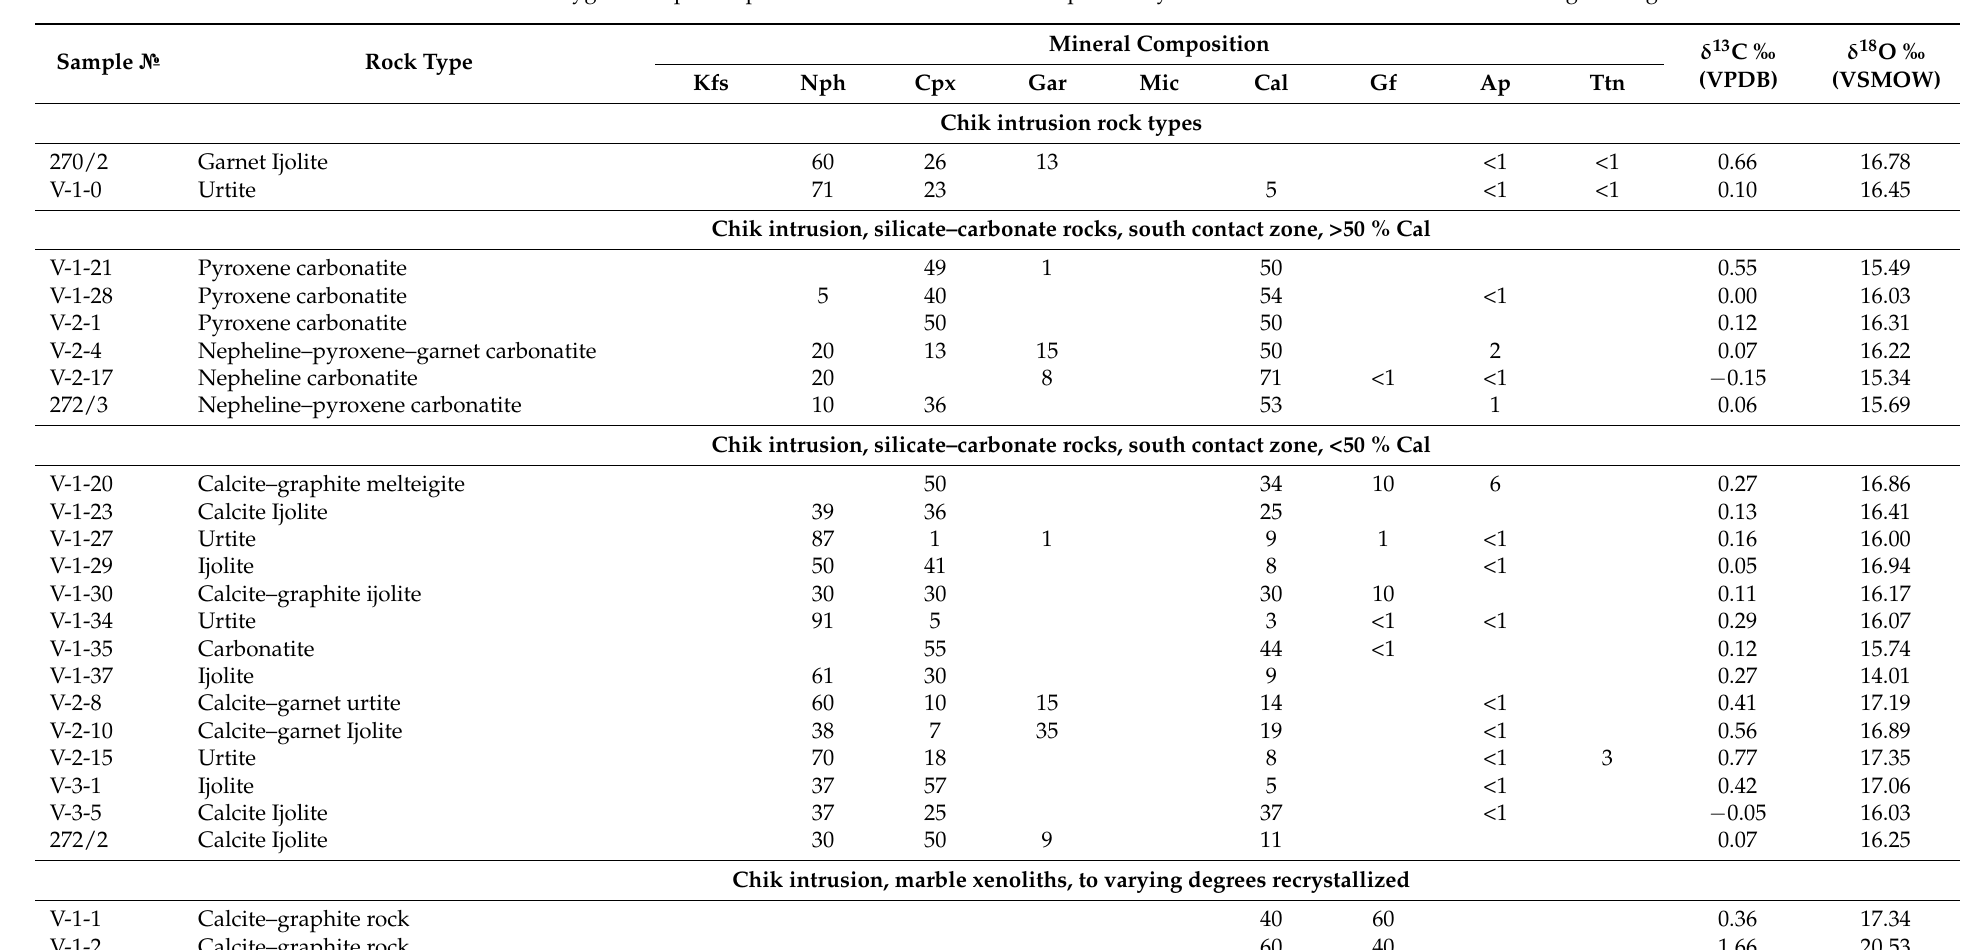
Table A1. Stable carbon and oxygen isotope compositions of calcite in rocks of nepheline syenite intrusions and host marbles of Sangilen